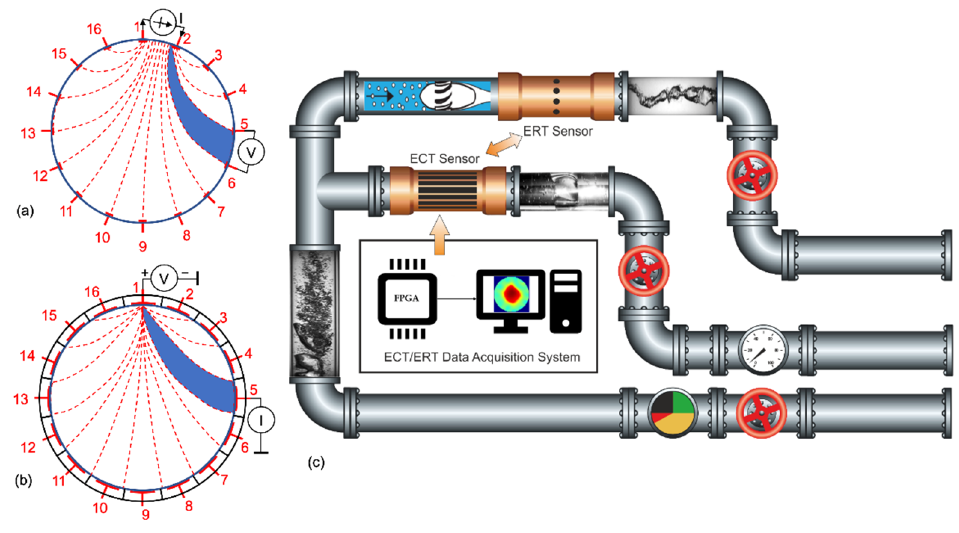
Figure 1. ( a ) Schematic of an ERT system. ( b ) Schematic of an ECT system. ( c ) Illustration of ECT and ERT systems mounted on flow installations. Red dashed lines in ( a , b ) delimit iso-potential areas represented by blue surfaces between the injection and measurement